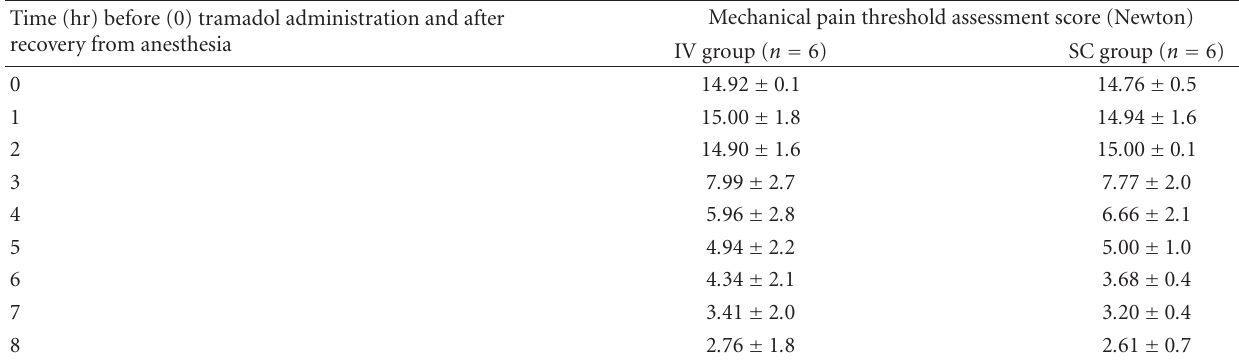
Table 1: Reaction times in the analgesiometer test demonstrate a progressive decrease in the mechanical pain threshold for dogs that received tramadol via both routes, indicating comparable increases in pain perception over time. The results are listed as the mean ± SD. Time (hr) before (0) tramadol administration and after